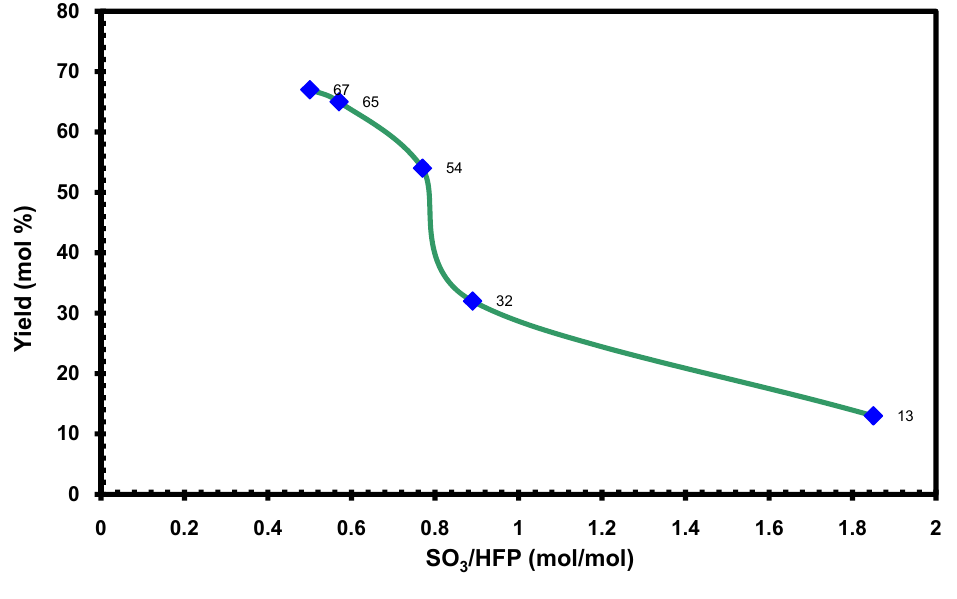
/HFP molar ratio at 37 3